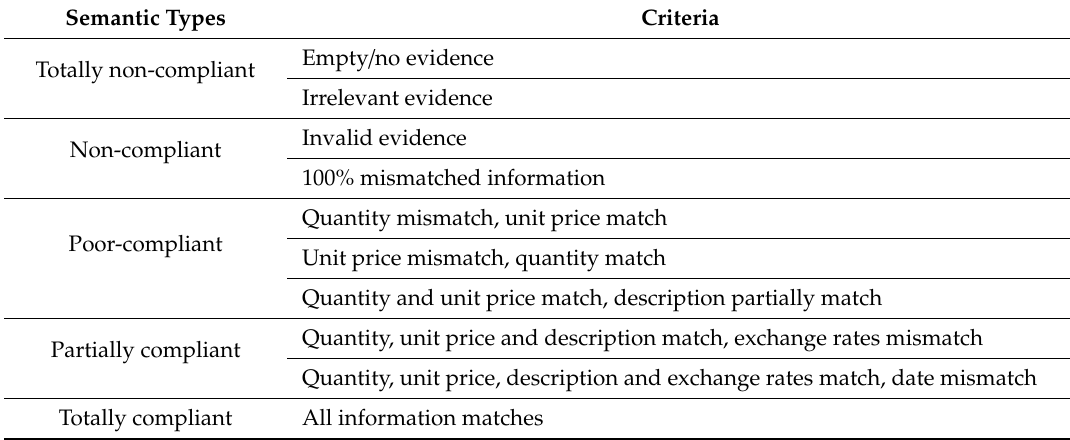
Table 1. The semantics of compliance levels in